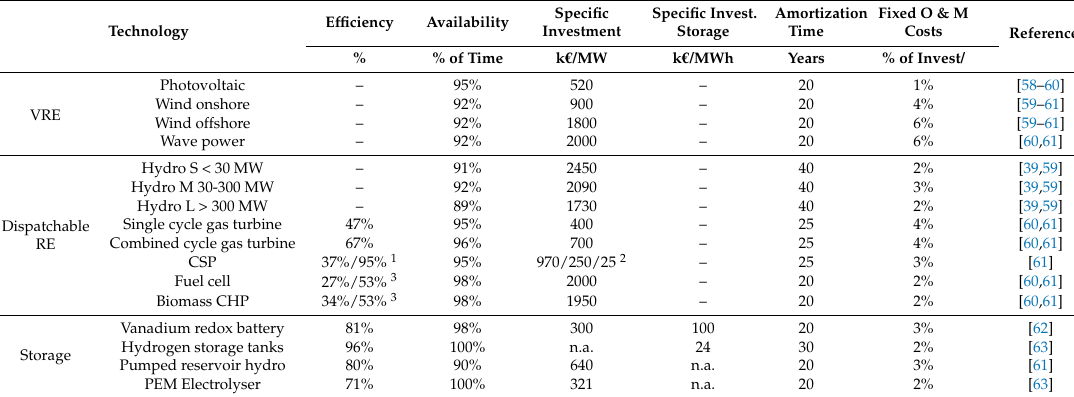
Table 3. Techno-economical parameters of considered RE